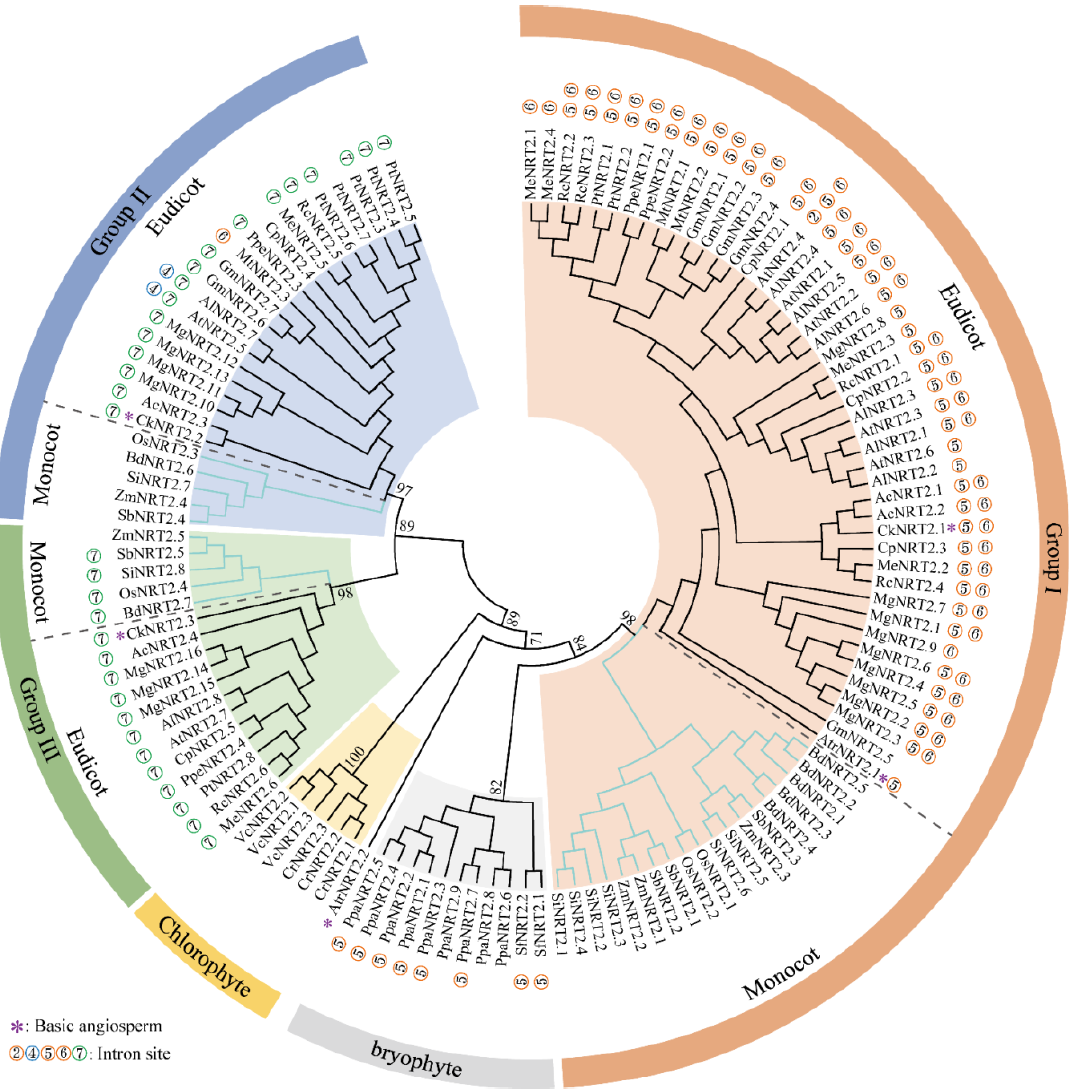
Figure 7. Phylogenetic analysis of NRT2 gene families in 22 plants. Different groups were colored by a special background. Monocot and eudicot within Groups I – III were divided by dashed lines. The number beside the branch indicates the bootstrap value of each group from 1000 replicates.